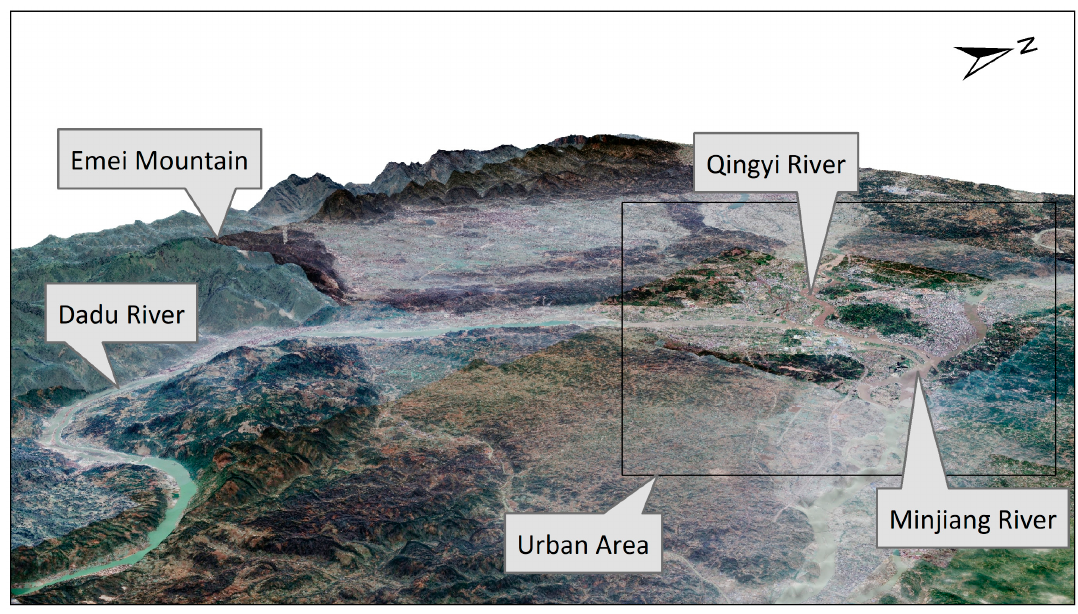
Figure 3. Three-dimensional geographic environment of LS and the surrounding area.